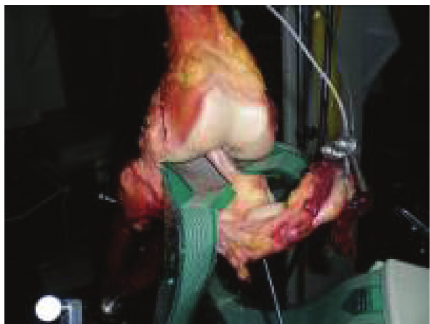
Figure 7: The location of Tecscan sensor.